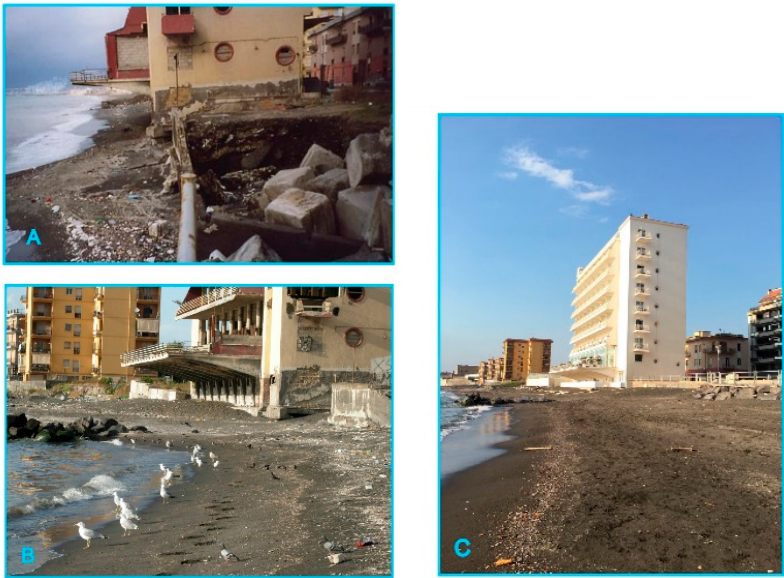
Figure 10. Recent evolution of the beach of the Miramare hotel. ( A , B ) the erosion processes had partially uncovered the foundations of the hotel structure. ( C ) weak progradation of the beach, now about 20 m wide.